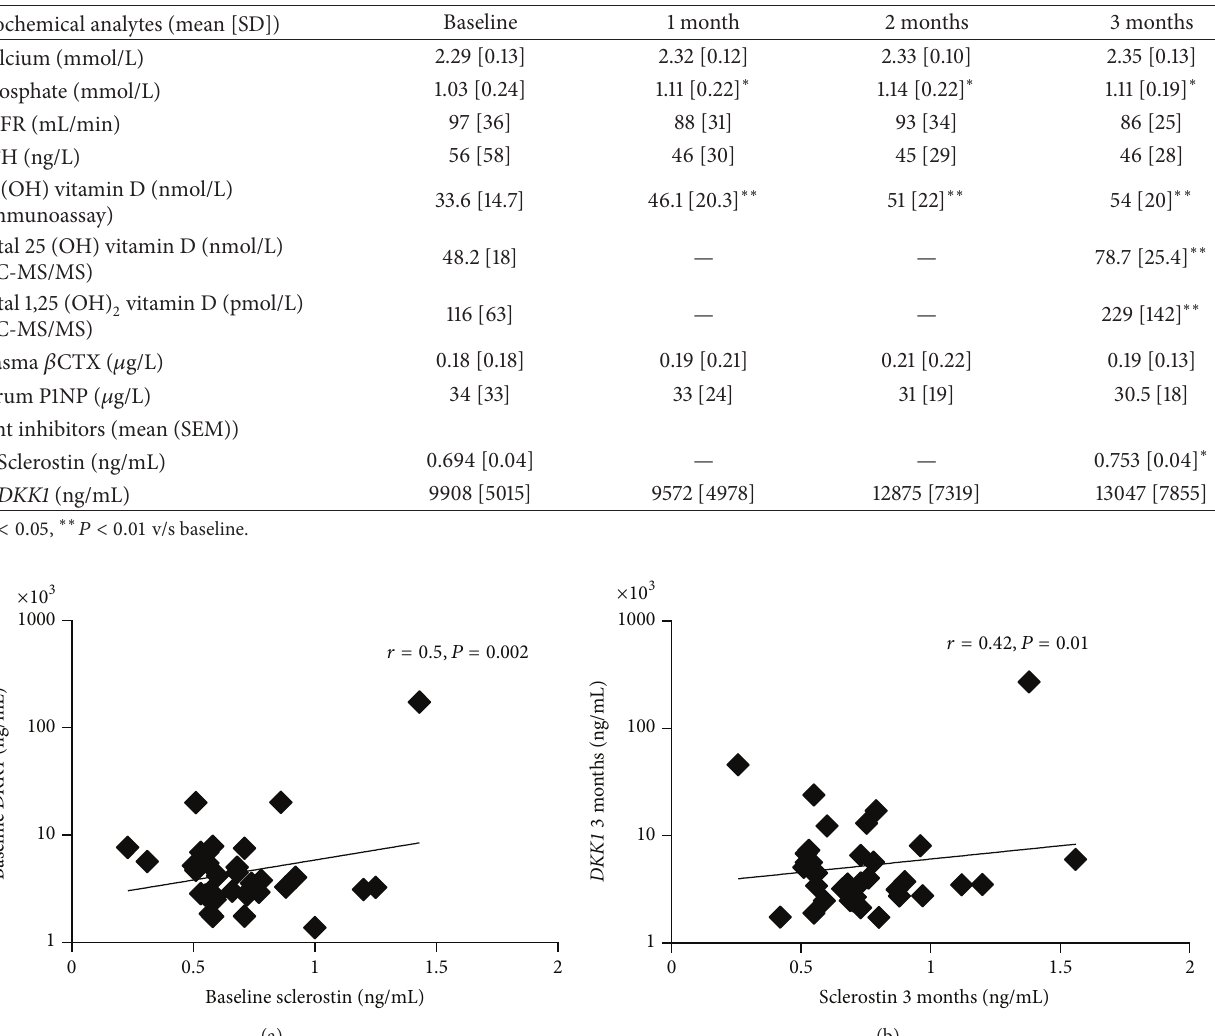
Table 2: Biochemical parameters and circulating concentration of sclerostin and DKK1 .